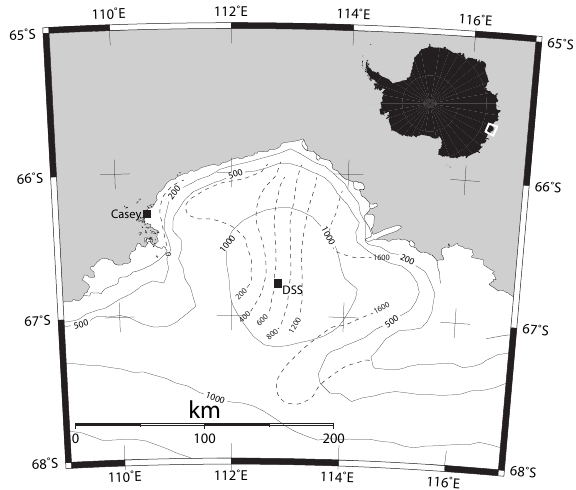
Fig. 1. Location of the Dome Summit South (DSS) sample site, Law Dome with surface elevation contours (m, solid lines) and ac- cumulation isopleths (mmiceequivalent, dashed